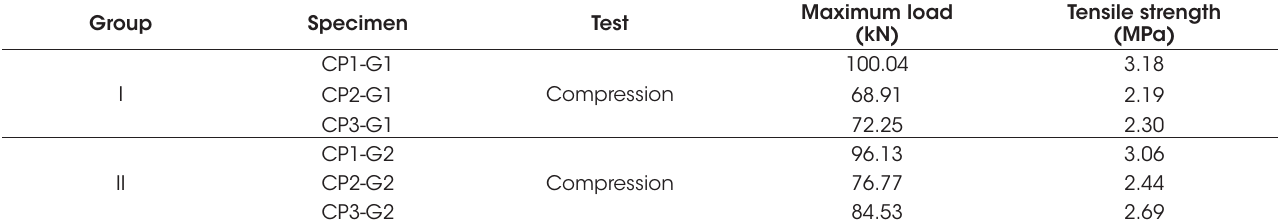
Specimens’ tensile strength Group